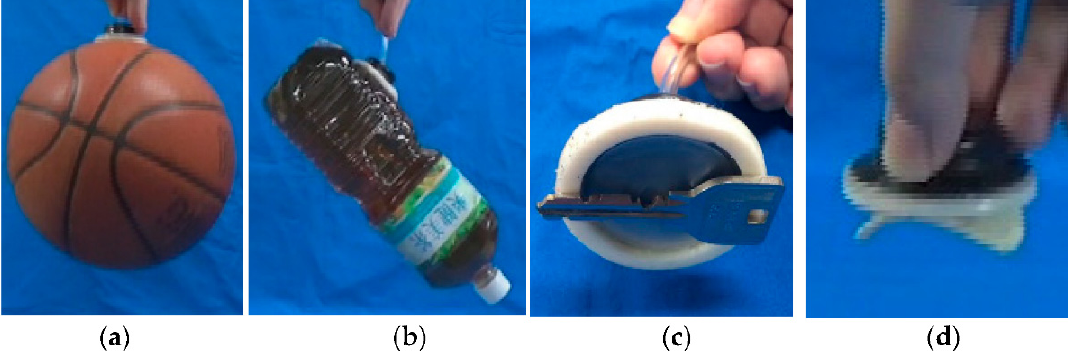
Figure 8. Photos of HS cup adsorbing and lifting the objects that conventional suction cups cannot handle: ( a ) a basketball; ( b ) a PET bottle containing 2 L of liquid; ( c ) a key; ( d ) a potato chip.